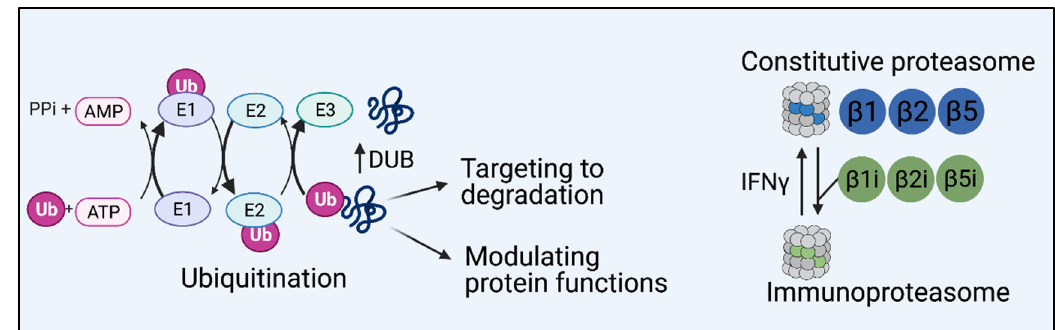
Figure 1. Zoom-in on ubiquitin-dependent protein degradation : Ubiquitin-dependent protein degradation is a multi-step process. Ubiquitin is loaded onto an E1-activating enzyme and transferred to an E2 conjugating enzyme. Ubiquitin E3 ligases recognize specific substrates and facilitate the conjugation of ubiquitination. Ubiquitinated proteins are then recognized by the 26S proteasome for degradation. The proteolytic subunits of constitutive proteasome are β1 (PSMB6), β2 (PSMB7), and β5 (PSMB5). IFNγ stimulates the formation of the immunoproteasome, which is composed of alternative catalytic subunits, namely, β1i (PSMB9 or LMP2), β2i (PSMB10 or MECL-1), and β5i (PSMB8 or LMP7) in turn of their constitutive counterparts. Substrates are deubiquitinated at the proteasome to allow for recycling of ubiquitin molecules and are unfolded and translocated into the proteasome where they are cleaved into peptides by the catalytic subunits [25,26,38–40].